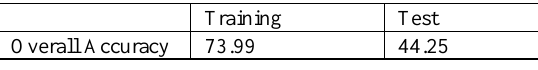
Table 3. Accuracy of the CNN